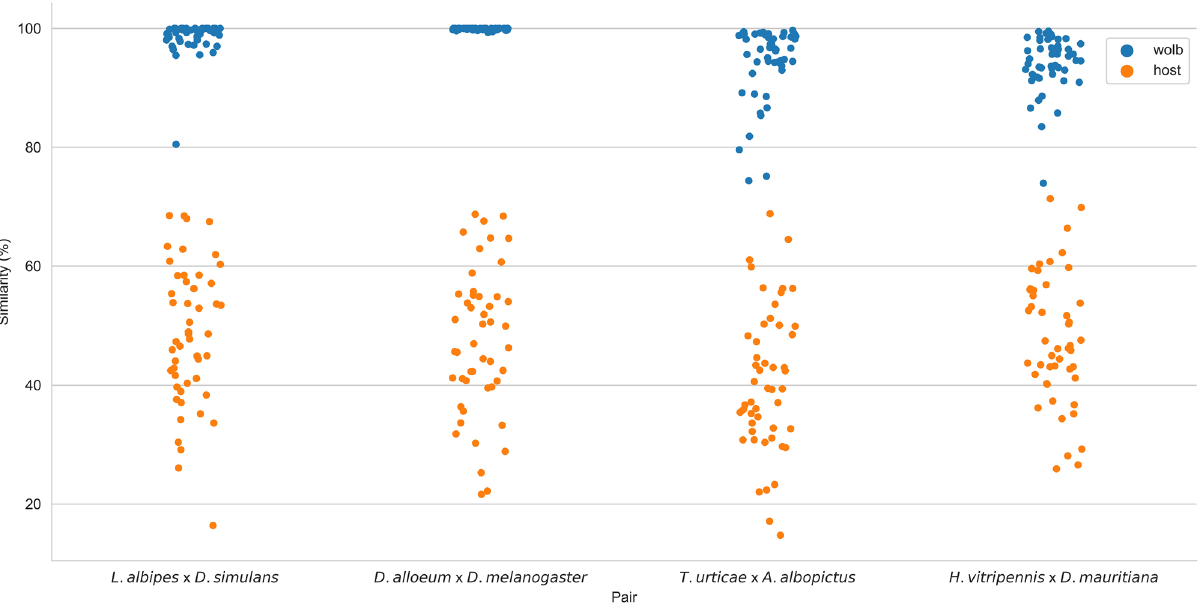
Figure 2. Pairwise gene similarity of Wolbachia and hosts. Each dot represents a gene pair (blue— Wolbachia genes; orange—host genes). It shows a higher similarity of Wolbachia orthologues when compared with their hosts orthologues